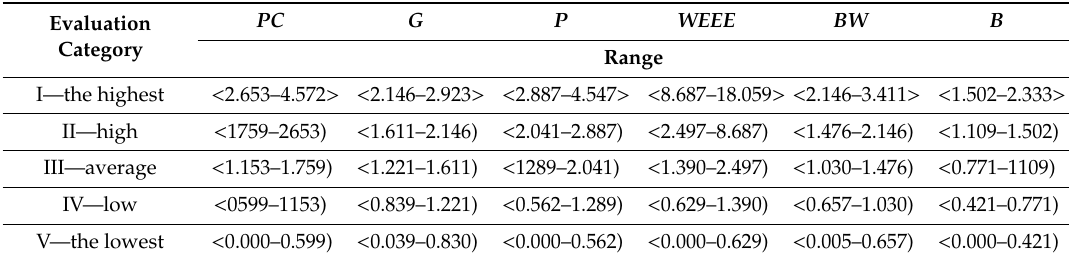
Table 2. The ranges of the categories of proper waste management for the analyzed fractions of selectively collected